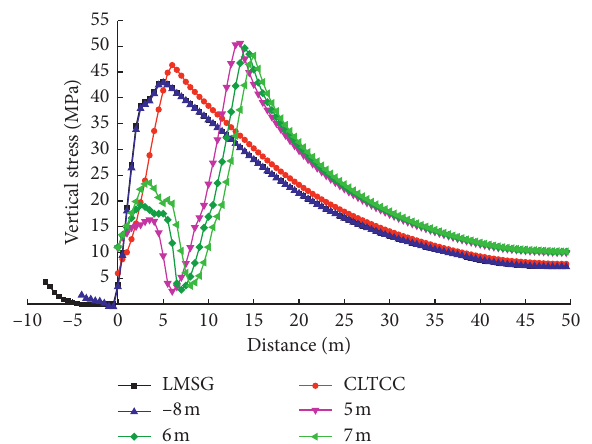
Figure 9: Vertical stress of solid coal.